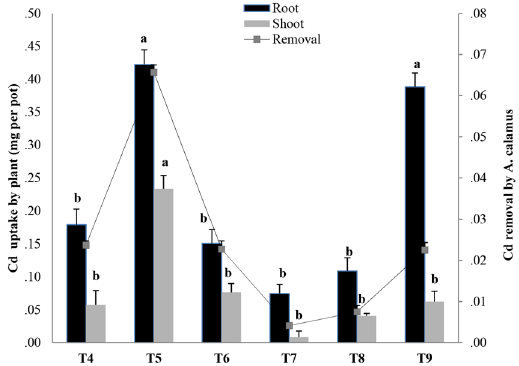
Figure 4. Cadmium (Cd) accumulation in plant tissues and percentage of Cd removed from soils co- contaminated with Cd and polycyclic aromatic hydrocarbons (PAHs) after 60 days of growth of Acorus calamus . Bars (mean ± SE, n = 3) with different letters (a,b,c) are significantly different based on the least significant difference test (p < 0.05). Treatments: C1P0 (T 4 ), C1P1 (T 5 ), C1P2 (T 6 ), C2P0 (T 7 ), C2P1 (T 8 ), and C2P2 ( T9 ). C0, C1, and C2 represent 0, 10, and 20 mg Cd kg − 1 ; P0, P1, and P2 represent 0, 50 + 25, and 100 + 50 mg PAHs kg − 1 with PHN + PYR, respectively.